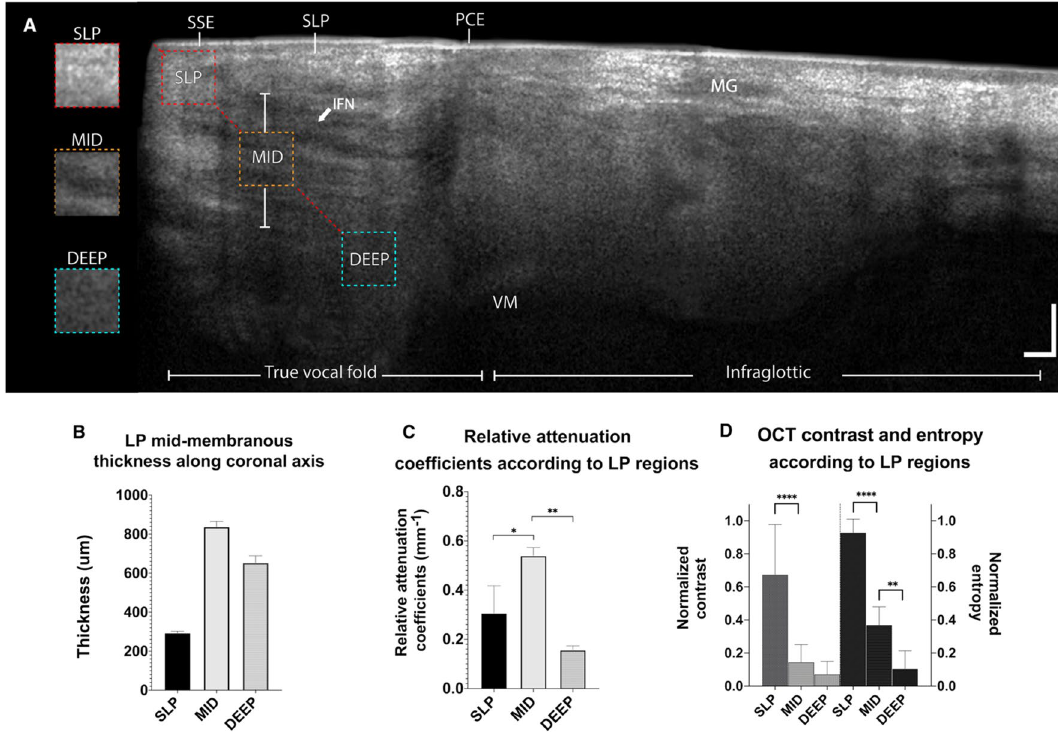
Figure 8. 50-year-old female mid-membranous vocal fold. OCT cross-section with quantitative analysis of OCT features. The epithelium is clearly delineated from the lamina propria (LP) under the true vocal fold and infraglottic. The infraglottic is characterized by thickening to the epithelium and by the presence of numerous seromucous glands. Underneath the superficial LP is highly scattering. Under the SLP, near the edge, a darker textured region is visible, which corresponds to the intertwined fiber network (IFN arrow) noticeable under multiphoton imaging. The deep LP shows a random speckle typical of an attenuated signal. Insets are representing the texture of each LP section in depth (A) . The thickness along the coronal axis was extracted (B) and relative attenuation coefficients (C) . The normalized texture contrast and entropy from the GLCM were extracted along the 45°. midline (dash-line) (D) . SSE stratified squamous epithelium; PCE pseudostratified ciliated epithelium; IFN intertwined fiber network; SLP superficial LP; MID mid LP; Deep deep LP; MG seromucous glands; VM vocalis muscle. Scale bars: 500